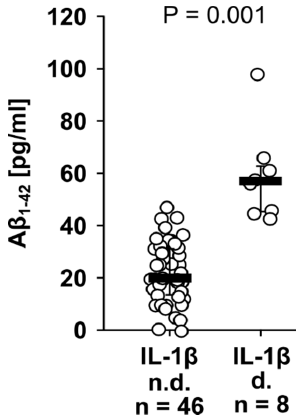
Figure 5. Interleukin-1 β (IL-1 β ) is predominantly detected in the blood of surgical patients together with increased amyloid beta (A β 1-42 ) levels. Blood was drawn from patients, who underwent major surgery, shortly before the operation ( n = 12), 0 to 2 h ( n = 10), 24 to 48 h ( n = 12), 72 to 96 h ( n = 12), and 7 to 9 days ( n = 8) after the operation. A β 1-42 and IL-1 β were measured by ELISA in patient blood plasma. A β 1-42 values of patients, in whom IL-1 β levels were below the threshold of detection (n.d.), were compared to patients with detectable IL-1 β (d). Data obtained for all time points were investigated collectively and are shown as individual data points, bar represents median, whiskers encompass the 25th to 75th percentile. Statistical analysis was performed using the Mann–Whitney U